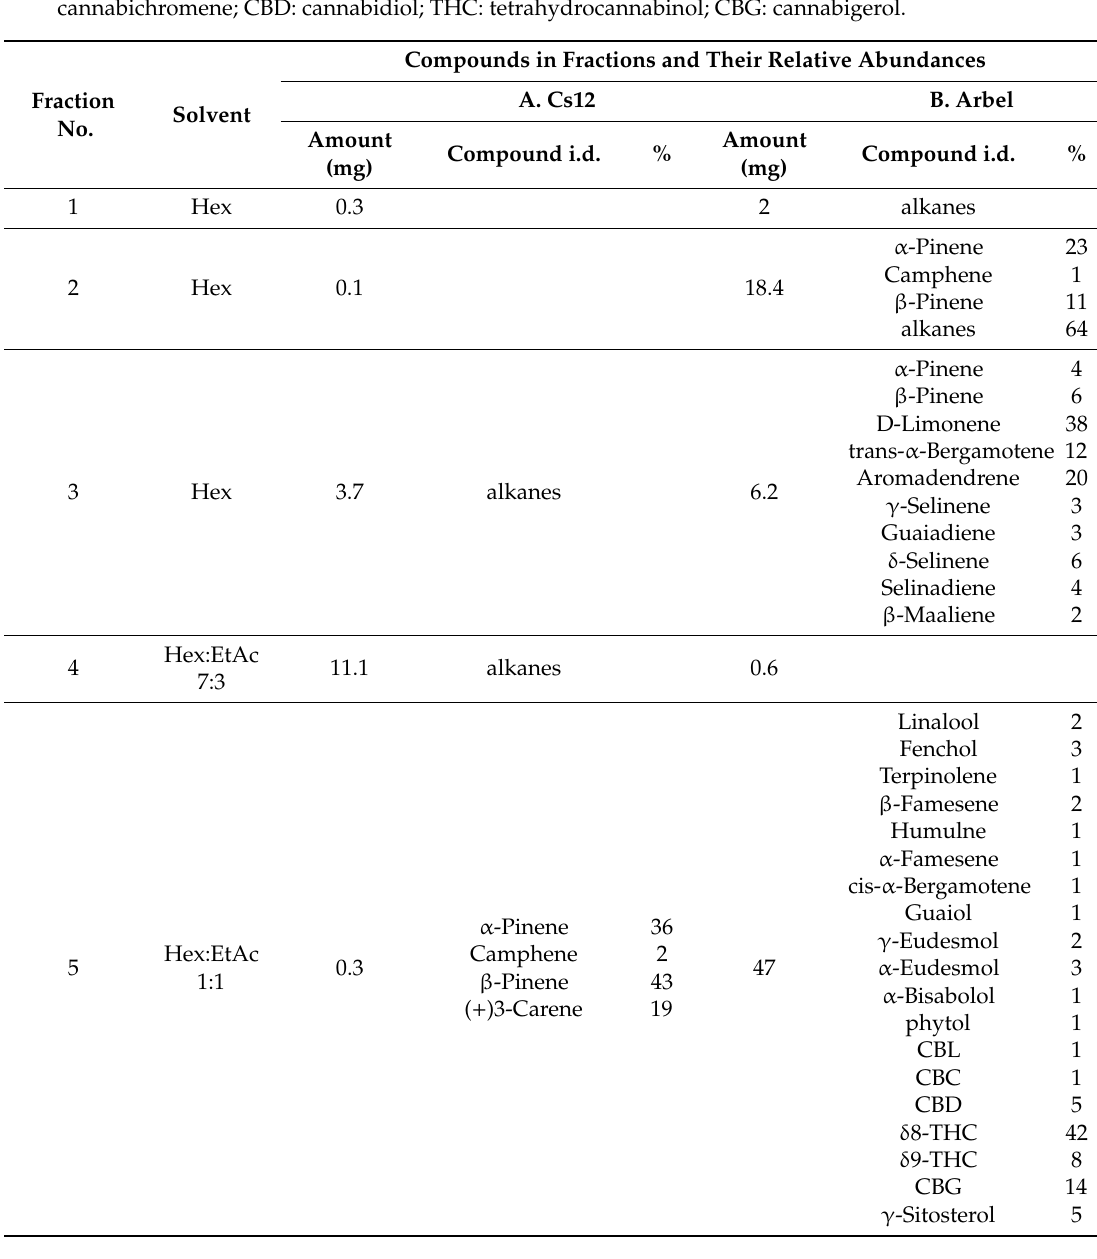
Table 1. Bulk separation results from the silica column, based on polarity and a ffi nity of terpenes and phytocannabinoids extracted from two commercial strains of cannabis: Cs12 (chemotype I)